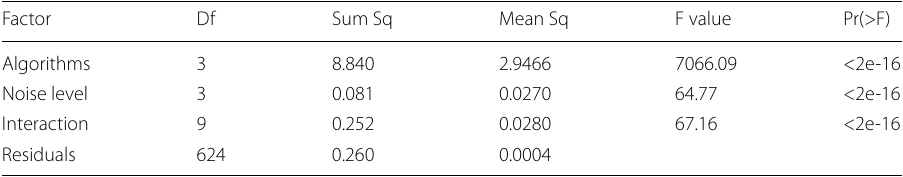
Table 3 Two-factor ANOVA for recall Factor